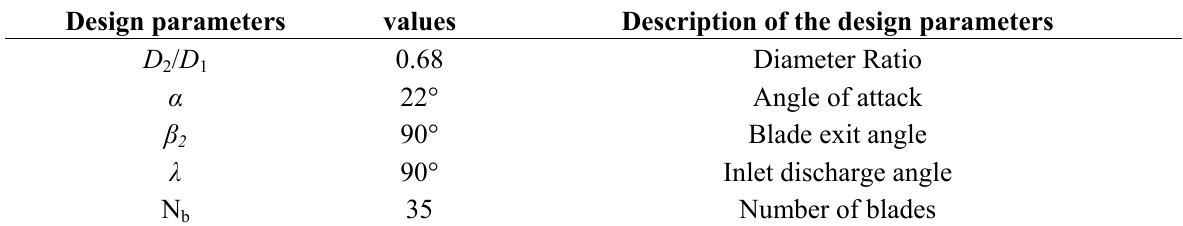
Table 1. Design parameters according to previous